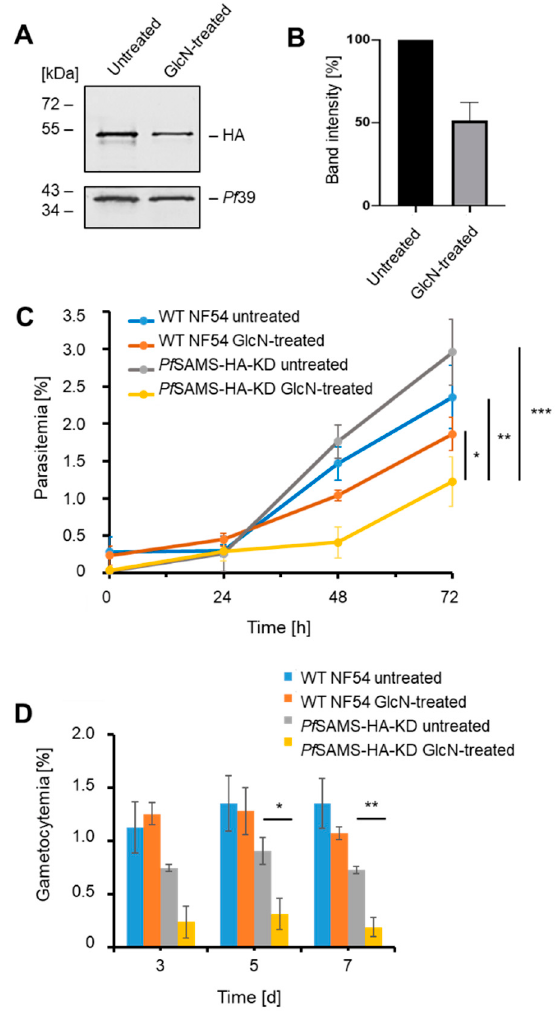
Figure 2. The effect of Pf SAMS-HA deficiency on intraerythrocytic growth and gametocyte development. ( A ) Downregulation of Pf SAMS-HA levels. Schizont cultures of the Pf SAMS-HA-KD parasite line were treated with 5 mM GlcN for 72 h to determine knockdown of PfS AMS. Lysates were immunoblotted with rat anti-HA antibody to detect Pf SAMS-HA (~50 kDa); immunoblotting with rabbit anti- Pf 39 antisera (39 kDa) was used as loading control. ( B ) Quantification of Pf SAMS-HA levels following knockdown. Pf SAMS-HA levels were evaluated between the GlcN-treated and untreated Pf SAMS-HA-KD parasites in three independent Western blots based on the band intensity as estimated with ImageJ software. Pf 39 levels were used for normalization (set to 100%). ( C ) Asexual blood-stage replication following Pf SAMS-HA knockdown. A highly synchronized Pf SAMS-HA-KD parasites ring stage culture was set up with a parasitemia of 0.25% and treated with 5 mM GlcN. The parasitemia was determined by Giemsa smears at 0 h, 24 h, 48 h, and 72 h. Untreated Pf SAMS-HA-KD cultures as well as GlcN-treated and untreated WT NF54 cultures were used as controls. ( D ) Gametocyte development following Pf SAMS-HA knockdown. A synchronized parasite culture of the Pf SAMS-HA-KD line was treated with 5 mM GlcN for 72 h, and gametocytogenesis was subsequently induced with lysed blood cells while the GlcN treatment was continued. The gametocytemia was evaluated by Giemsa smears on days 3, 5, and 7. Untreated Pf SAMS-HA-KD cultures as well as GlcN-treated and untreated WT NF54 cultures were used as controls. Statistical analyses were performed using one-way ANOVA; p > 0.05; * p < 0.05; ** p < 0.01; *** p < 0.001. The results are representative of three ( C ) and one ( D ) independent experiments.